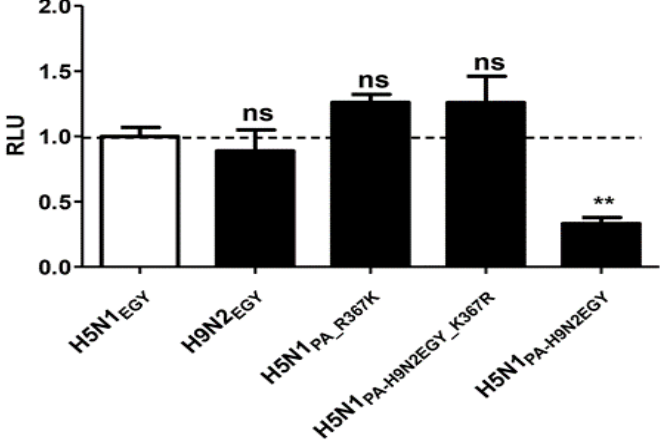
Figure 8. PA-367K does not significantly alter the in vitro polymerase activity of H5N1 EGY in human 293T cells. The 293T cells were transfected with plasmids expressing the three subunits (PB2, PB1, PA) of the viral RNA-dependent RNA polymerase (RdRp) and the viral nucleoprotein (NP) of H5N1 EGY or H9N2 EGY (controls) or combinations of H5N1 EGY PB2, PB1 and NP with mutated PA of H5N1 EGY (PA_R367K) or of H9N2 EGY (PA-H9N2EGY_K367R), as well as wild-type PA of H9N2 EGY (PA-H9N2EGY). Along with the three RdRp subunits and NP expressing plasmids, a Renilla luciferase expression plasmid (transfection control) and a vector expressing a vRNA-like Pol-1 transcript encoding the firefly luciferase was co-transfected. At 48 h p.t., the control and transfected cells were analyzed for Renilla / luciferase expression levels. The significance was tested using one-way analysis of variance ANOVA, followed by Dunnett’s multiple comparison post hoc test and the significant differences are indicated (** = p < 0.01 and non-significant = ns).